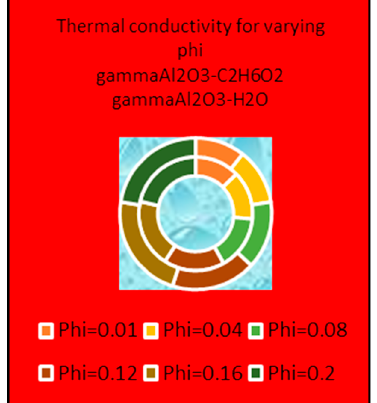
Figure 13. Effects of 𝜙 on ( a ) dynamic viscosity ( b ) thermal conductivity